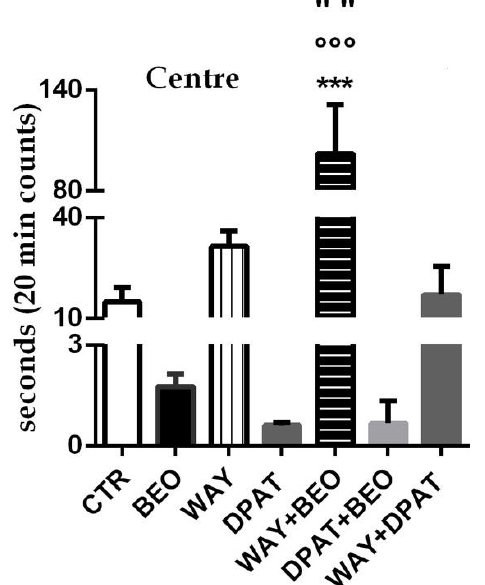
Figure2. TimespentintheCenterinopenfieldtestinmaleWistarratsaftersystemic(i.p.) administration Figure 2. Time spent in the Center in open field test in male Wistar rats after systemic (i.p.) of jojoba oil (CTR) (500 µ L / kg), Bergamot Essential Oil (BEO) (500 µ L / kg), WAY100635 (WAY) (1 mg / kg), administration of jojoba oil (CTR) (500 µL/kg), Bergamot Essential Oil (BEO) (500 µL/kg), 8-OH-DPAT (DPAT) (1 mg / kg), WAY + BEO (1 mg / kg + 500 µ L / kg), DPAT + BEO (1 mg / kg + 500 µ L / kg), WAY100635 (WAY) (1 mg/kg), 8-OH-DPAT (DPAT) (1 mg/kg), WAY + BEO (1 mg/kg + 500 µL/kg), and WAY + DPAT (1 mg / kg + 1 mg / kg). Data are expressed as mean ± SEM (n = 5–6 per group). DPAT + BEO (1 mg/kg + 500 µL/kg), and WAY + DPAT (1 mg/kg + 1 mg/kg). Data are expressed as *** p < 0.001 vs. control group; ◦◦◦ p < 0.001 vs. BEO group; “” p < 0.001 vs. WAY group. Statistical mean ± SEM (n = 5–6 per group). *** p < 0.001 vs. control group; °°° p < 0.001 vs. BEO group; “” p < analysis was performed by one-way ANOVA followed by individual comparisons with Tukey Multiple 0.001 vs. WAY group. Statistical analysis was performed by one-way ANOVA followed by Comparison’s individual comparisons with Tukey Multiple Comparison’s test.